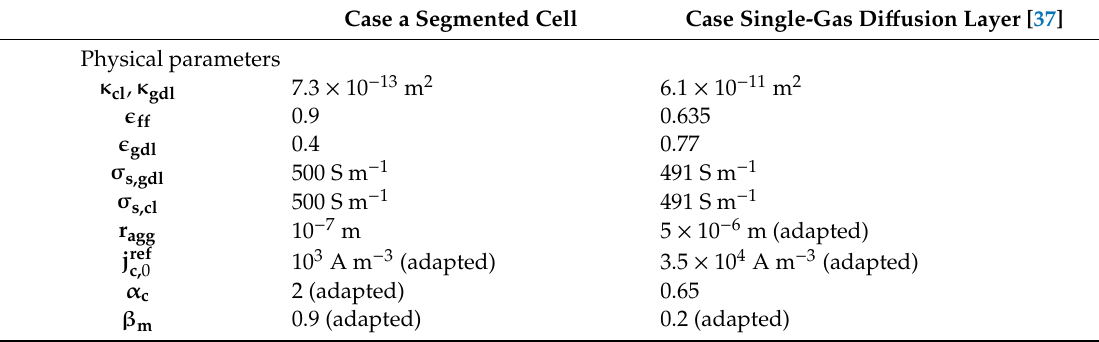
Table 1. Geometrical and operating parameters for two PEMFC experimental data